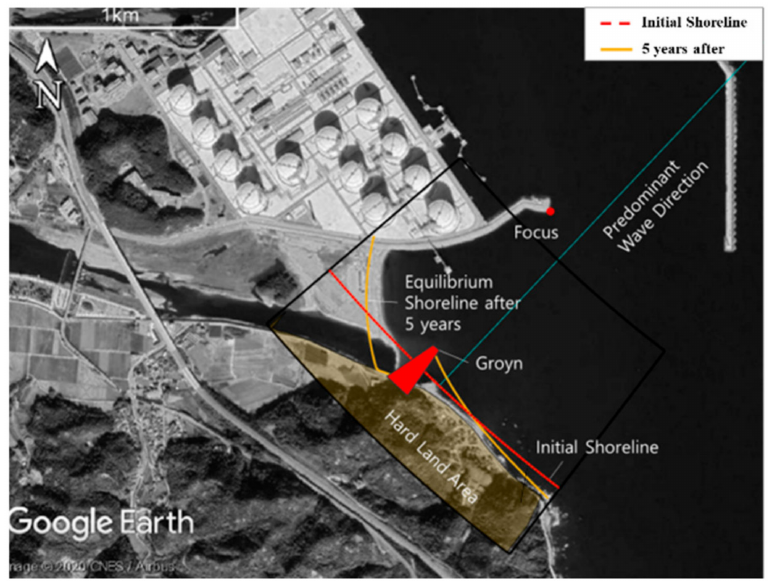
Figure 19. Shoreline change model simulation of prevention of loss of sand from Wolcheon beach through construction of groin (image from Google Earth as at November